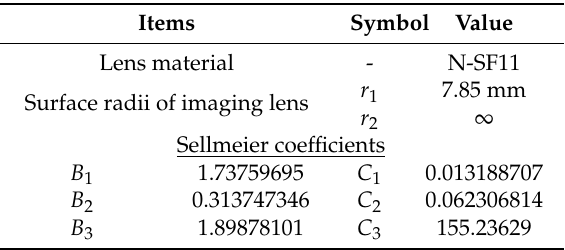
Table 1. Parameters employed for the theoretical calculation.